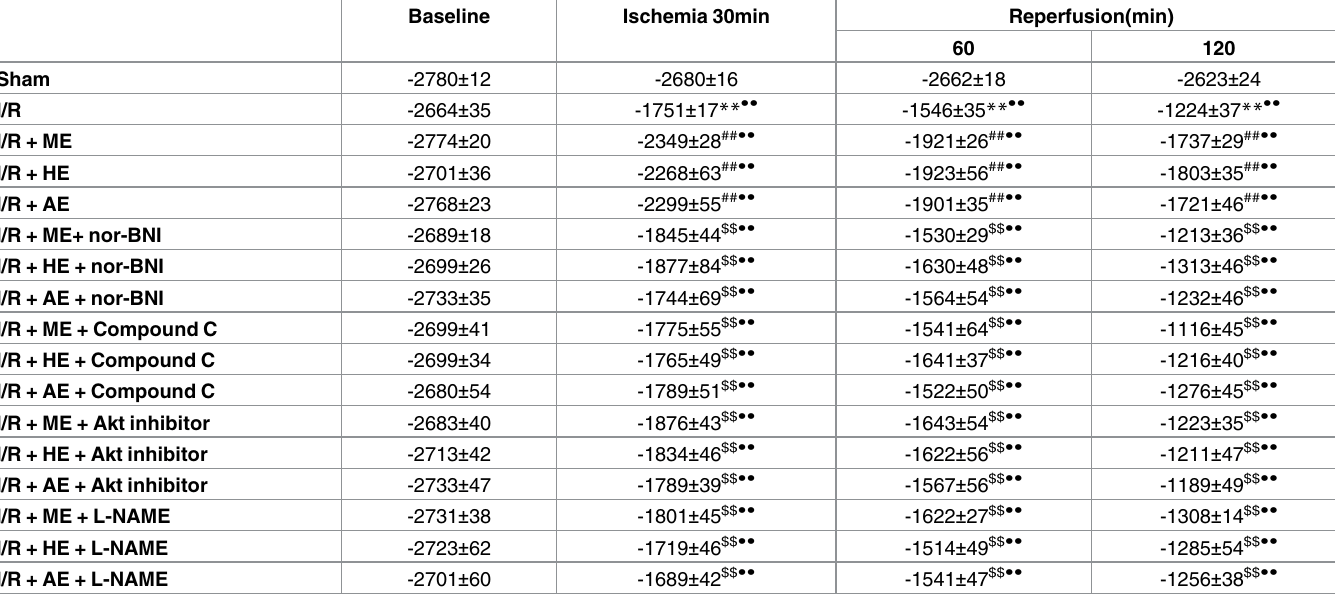
Table 4. Changes in -dP/dtmax (mm Hg/s) during myocardial I/R.